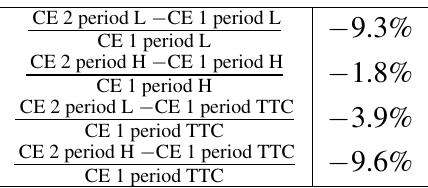
Table 1. Expected